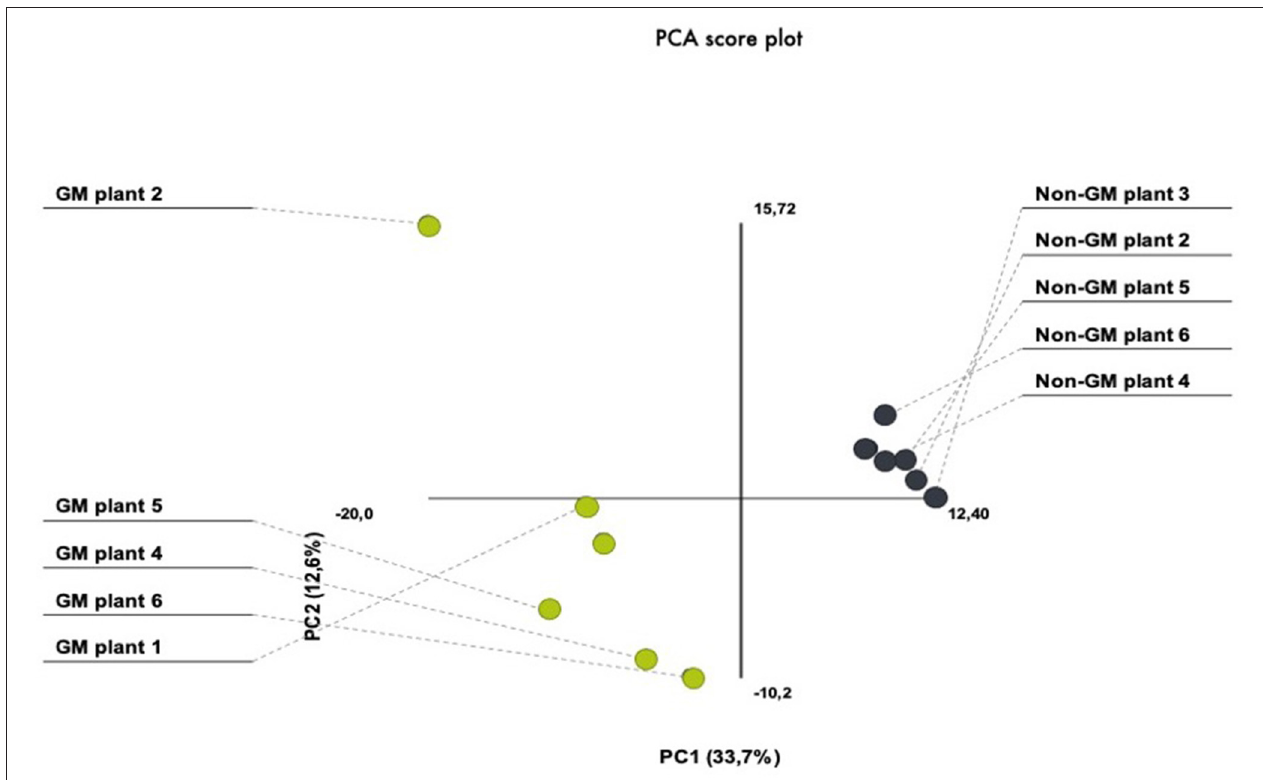
FIGURE 2 | PCA score plots of 2-D proteomic data from transgenic (MON810 event) and non-transgenic near-isogenic maize plants (PAN 6Q-121) grown side-by-side under agricultural conditions at Bloemfontein, South Africa.